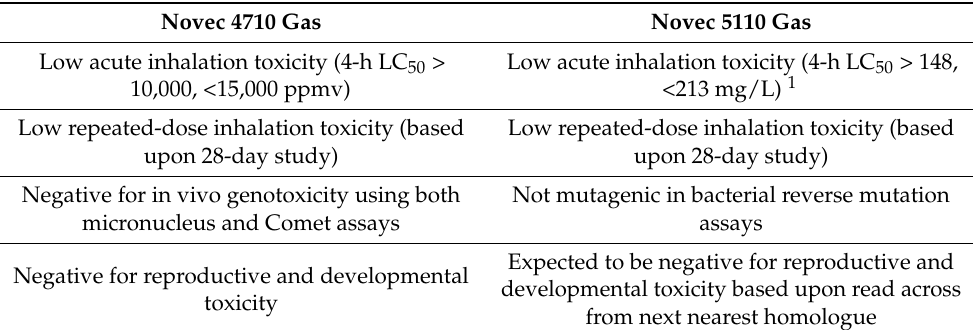
Table 3. Key toxicological results on pure Novec Insulating